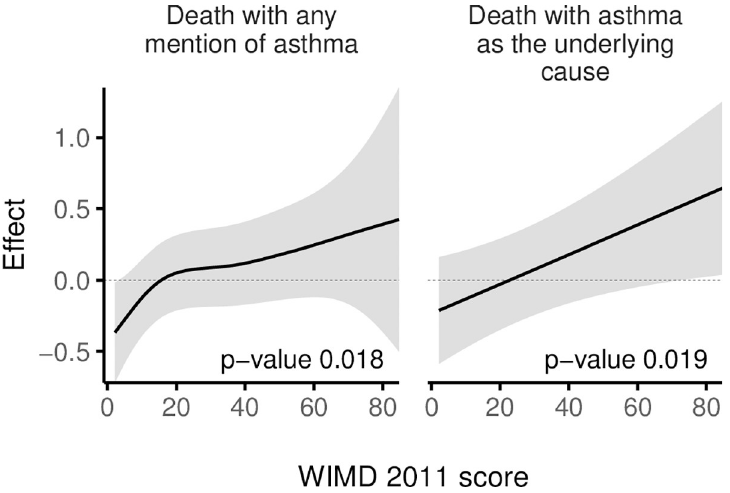
Fig 9. Smooths from GAMs of asthma deaths by the WIMD 2011 score, controlled for age and gender. The shaded area represents the 95% CI of effect. CI, confidence interval; GAM, generalised additive model; WIMD, Welsh Index of Multiple